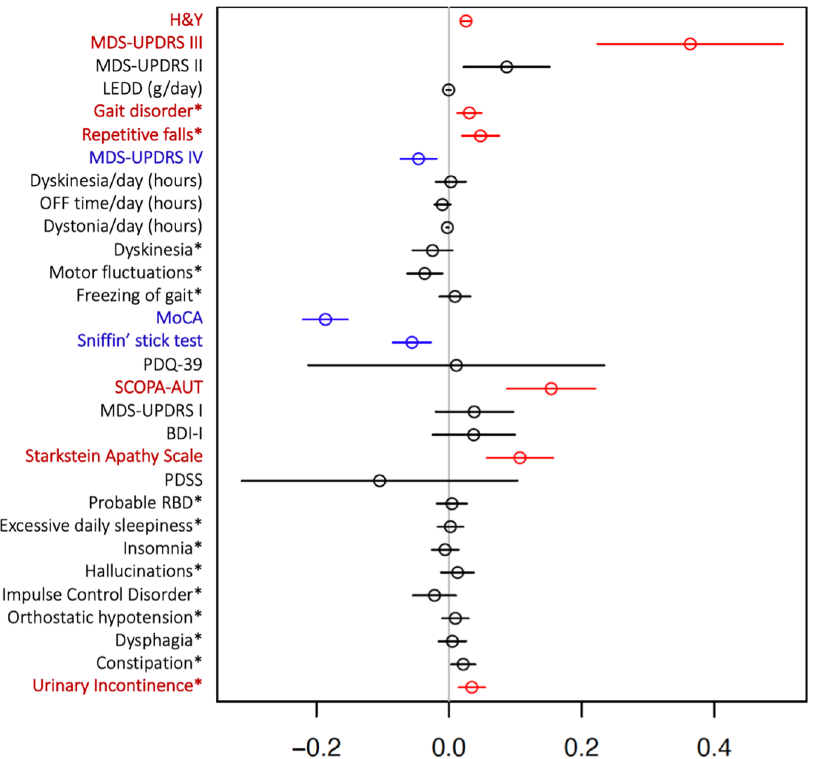
Fig. 1 Forrest plot with estimated coef fi cients and corresponding con fi dence intervals (±1.96 × standard error) for AAO, from linear/ logistic regression of numerical/binary outcome on disease duration and AAO. The colour blue indicates signi fi cant negative effects of AAO on the clinical outcome, and the colour red indicates signi fi cant positive effects at the Bonferroni-adjusted 5% level. The binary variables are annotated by asterisk. Clinical symptoms and scales are described in Supplementary